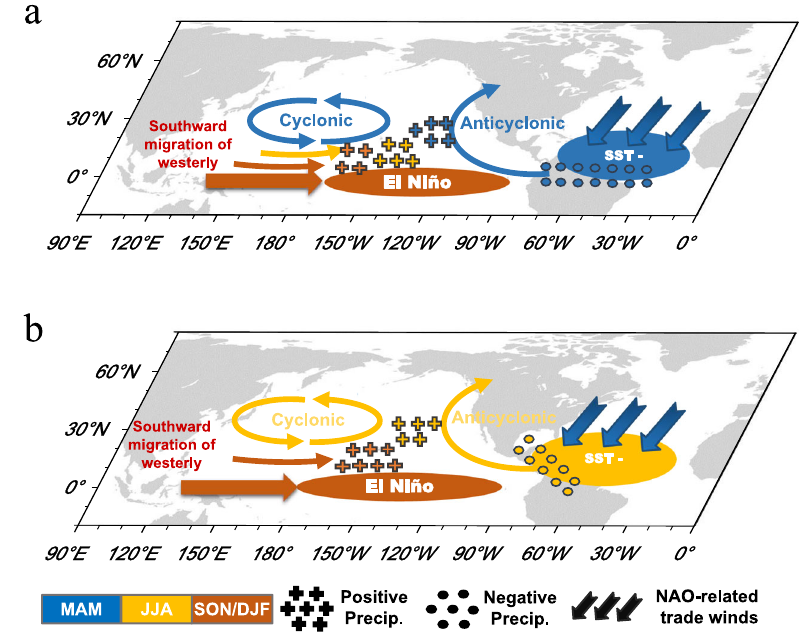
Fig. 5 | Schematic representation of two major mechanisms behind the North Atlantic Oscillation(NAO)modulation ofthe North TropicalAtlantic(NTA) − El Niño-Southern Oscillation (ENSO) connection (motivated by Fig. 3 in Kug et al. 20 ). a NAO modulation of background mean-state precipitation over the equatorial Atlantic. The intensi fi ed northeasterly trade winds associated with the positive NAO favor stronger background mean-state precipitation over the equa- torialAtlanticduring borealspring. Thewetterbasicstate wouldlead toa stronger negative precipitation anomaly response to a negative NTA sea surface tempera- ture (SST) anomaly (SST − ), thereby exciting stronger subtropical teleconnections